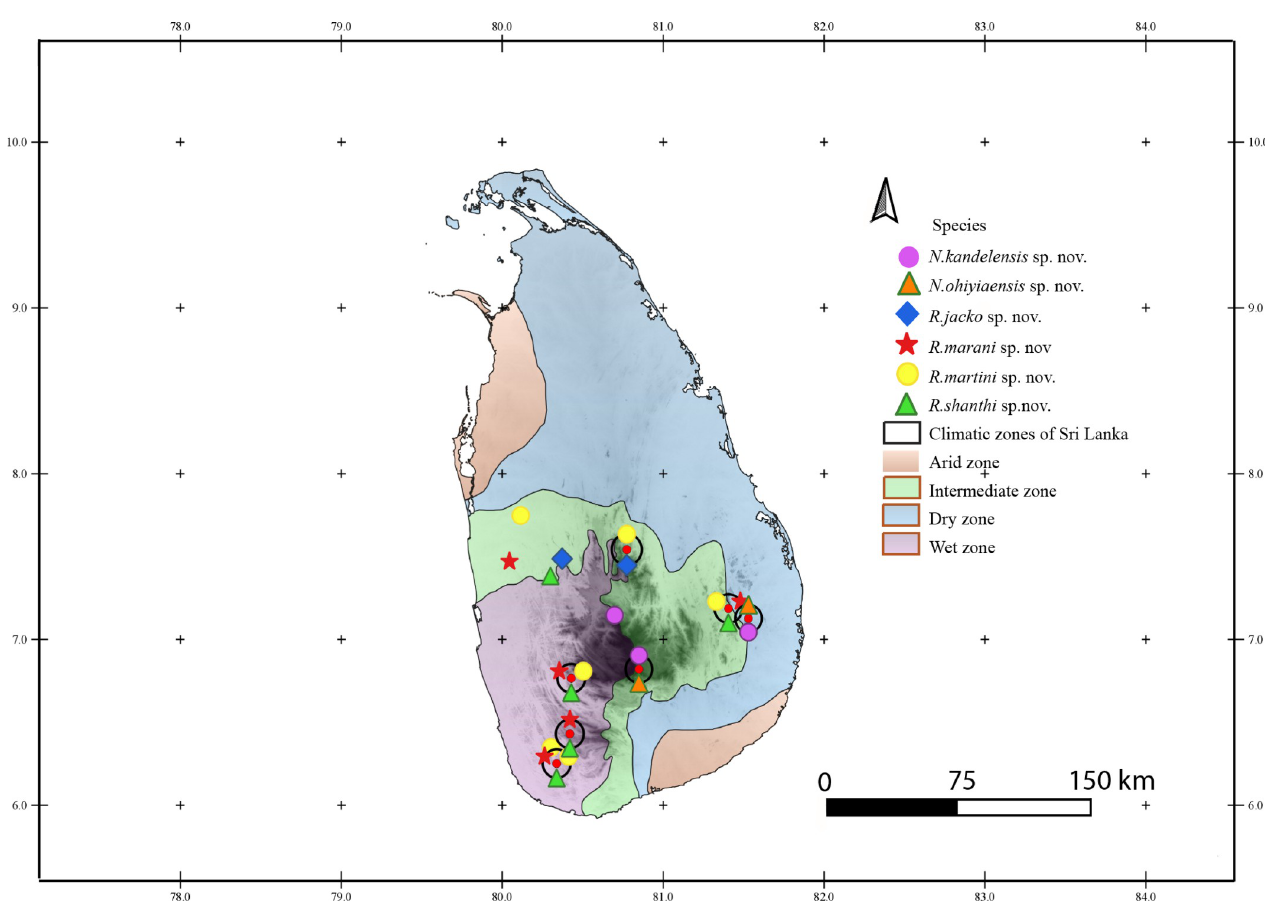
Fig 11. Distribution of Rhomphaea and Neospintharus species described from Sri Lanka. The localities of R . shanthi sp. nov. are represented with green triangles, R . jacko sp. nov. with blue diamond, R . martini sp. nov. with yellow circle, R . marani sp. nov. with red star, N . kandelensis sp. nov. with purple circle and N . ohiyiaensis sp. nov. with orange triangle outlined in